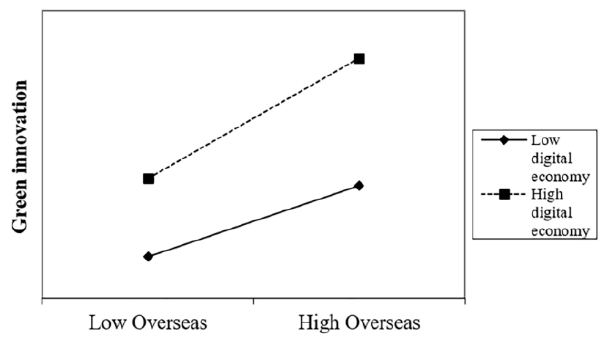
Figure 3. The moderating effect of digital economy.